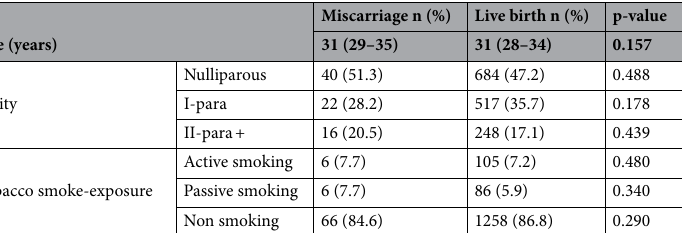
Table 1. Description of the study population of miscarriage cases (N = 78) and singleton live birth (N = 1449). Numbers are presented as median (IQR) for age and N (%) for parity and smoke exposure. P-values for difference between miscarriage cases and live birth pregnancies.